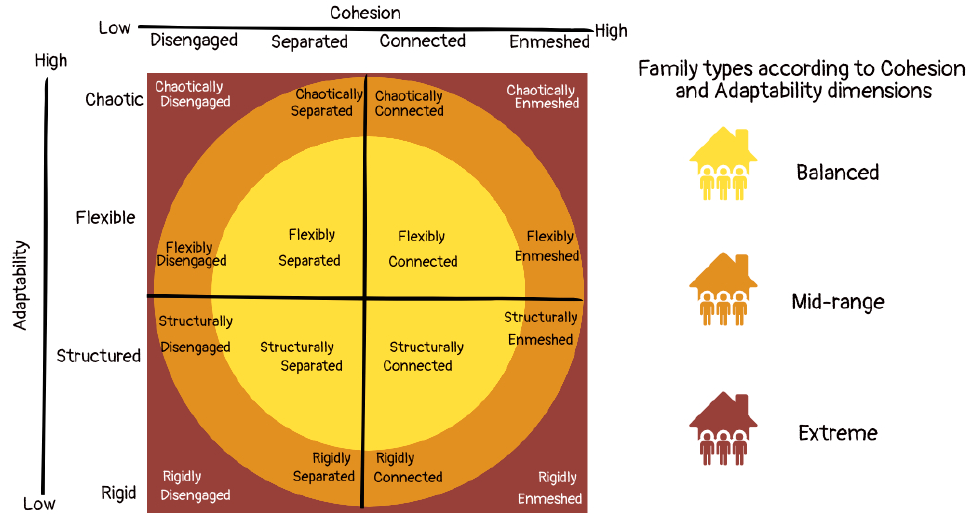
Figure 1. Diagram of Olson’s circumplex model showing the family types (modified from Hanson and Keplinger, 2020)